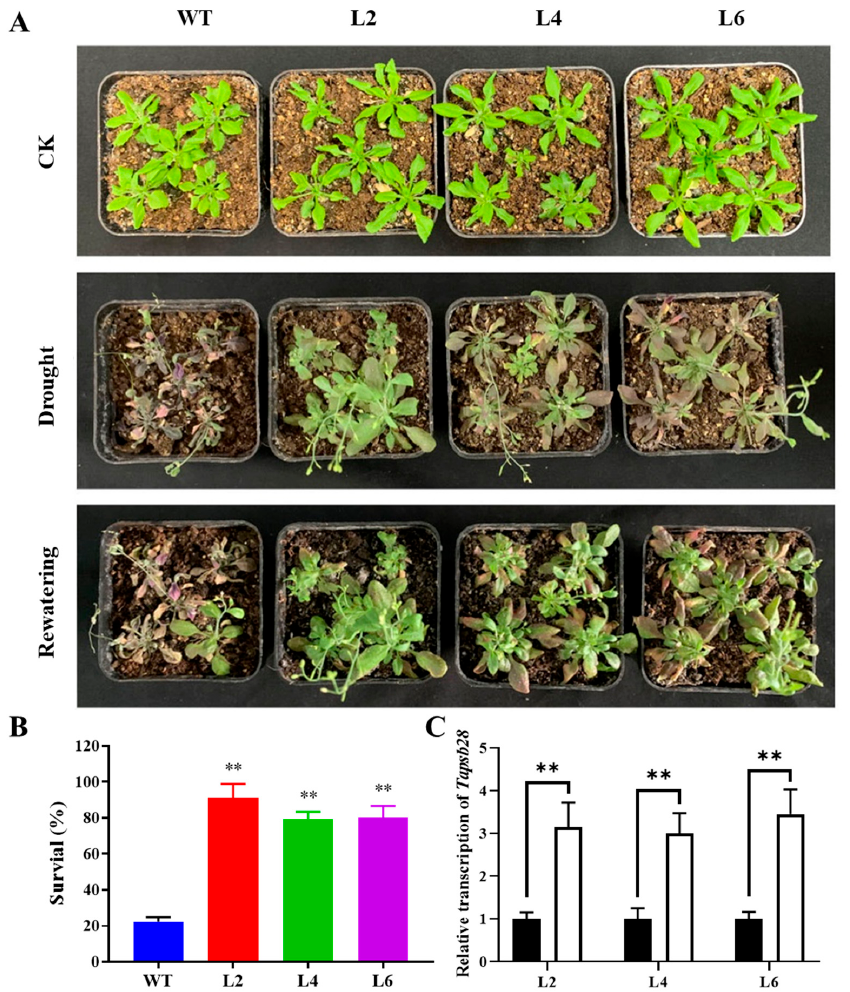
Figure 6. Phenotypic effects of TaPsb28 overexpression in Arabidopsis seedlings exposed to drought treatment. ( A ) Growth status of Arabidopsis lines under different treatments; ( B ) Comparison of survival rate of overexpression lines after 5 days of rewatering followed by 14 days of drought stress by withholding irrigation; ( C ) qRT–PCR analysis of TaPsb28 gene transcription in the transgenic plants. The black column represents the plants treated by normal watering, while the white column represents the plants subjected to drought stress by withholding irrigation for 14 days. Data are the means ± SDs ( n = 3). “**” indicates statistically significant differences between the transgenic and WT plants in ( B ) or between drought and CK treatment in ( C ) at p <